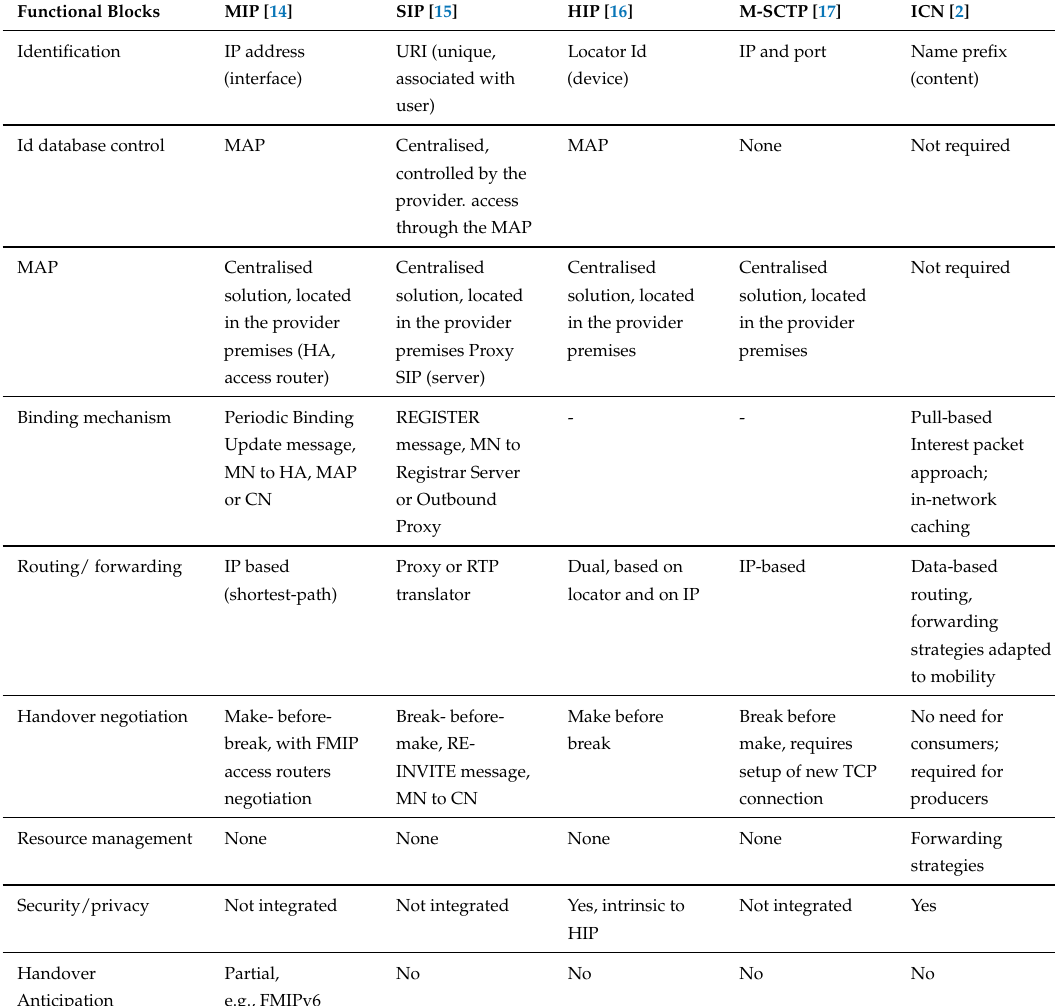
Table 1. Mobility management functional blocks, support in different mobility management